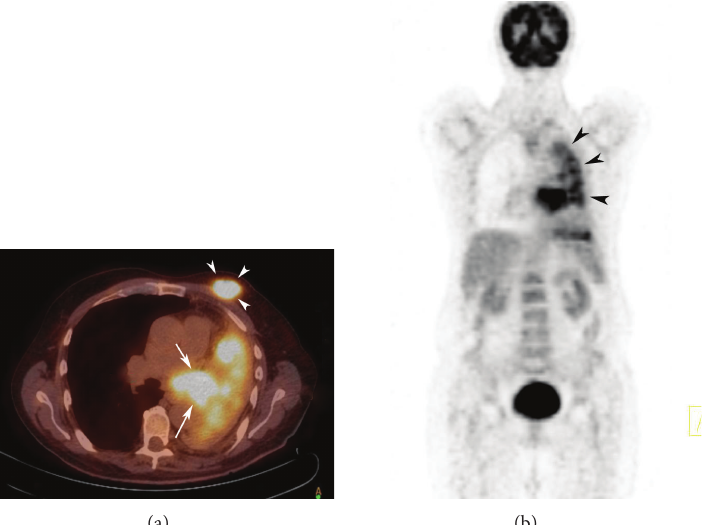
Figure 4: PET/CT demonstrates a primary lung cancer (arrows) at left hilar region and hypermetabolic masses with a high FDG uptake in left breast (arrow heads), consistent with metastasis (a). Whole body PET/CT was not positive for an FDG uptake suggesting metastasis in an organ other than the left breast. Nodular multiple high FDG uptake at the lateral part of the left lung was considered a false positive pleural uptake (arrow heads)